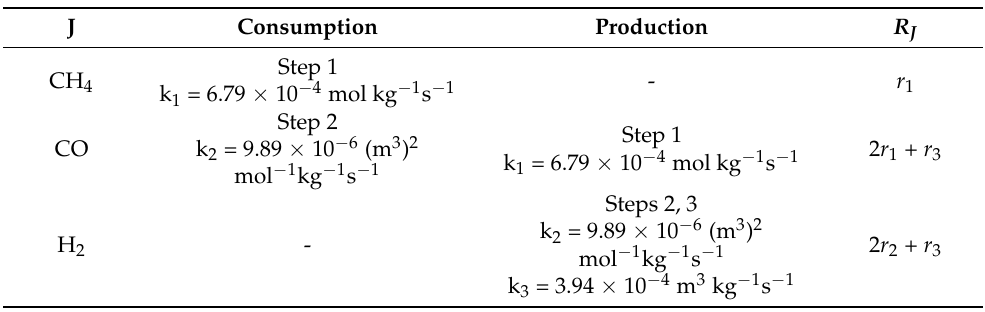
Table 6. Reaction rates of the dry reform of methane. Conditions: Ni (4.82 wt.%)/ γ -Al 2 O 3 ,1023 K, 1.0 bar [5].